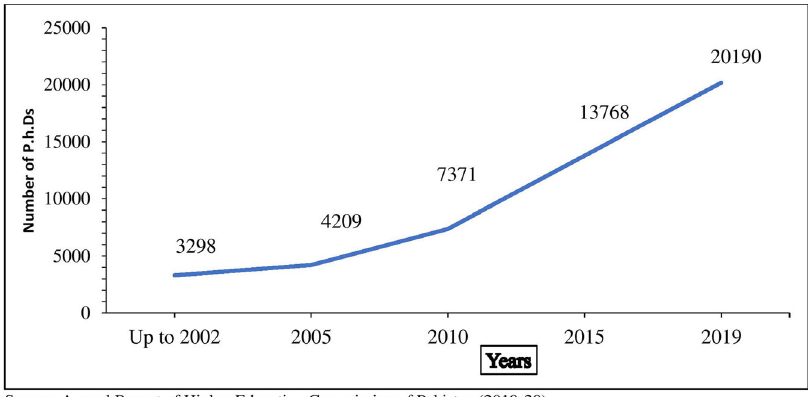
Fig. 2 Number of Ph.D. produced by Pakistani Universities over time. The vertical and horizontal axis explains the number of Ph.D. degree holders and time frame, respectively. It shows an increasing trend in the number of Ph.D. degree holders over